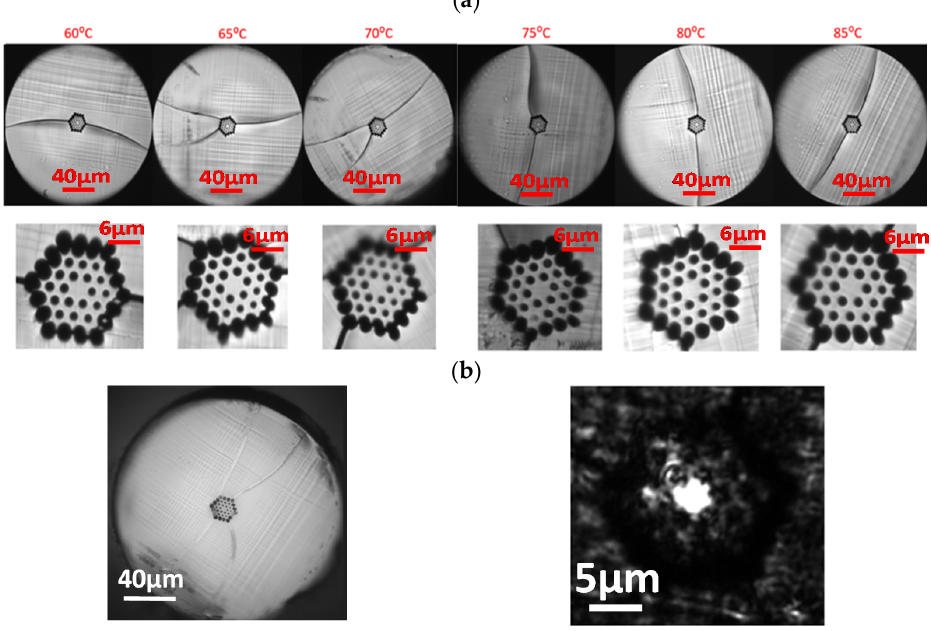
Figure 10. ( a ) 3-ring mPOF end faces at different blade temperatures from 60 °C to 85 °C, at a blade cutting speed of 0.5 mm/s after blade treatment. ( b ) Ouptut light pattern obtained for a 3-ring mPOF after fiber cleaving.